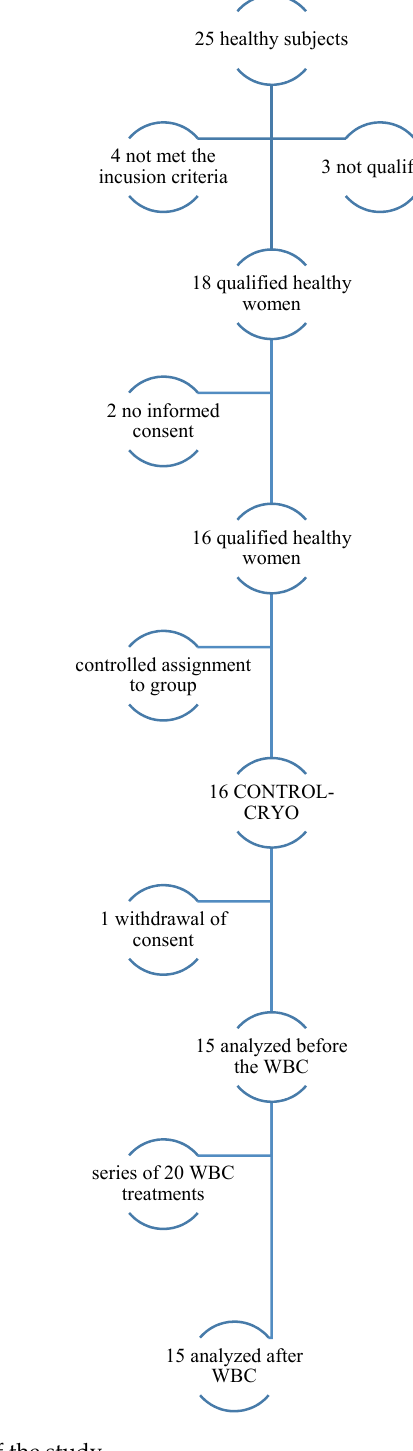
Figure 1. The course of the study.